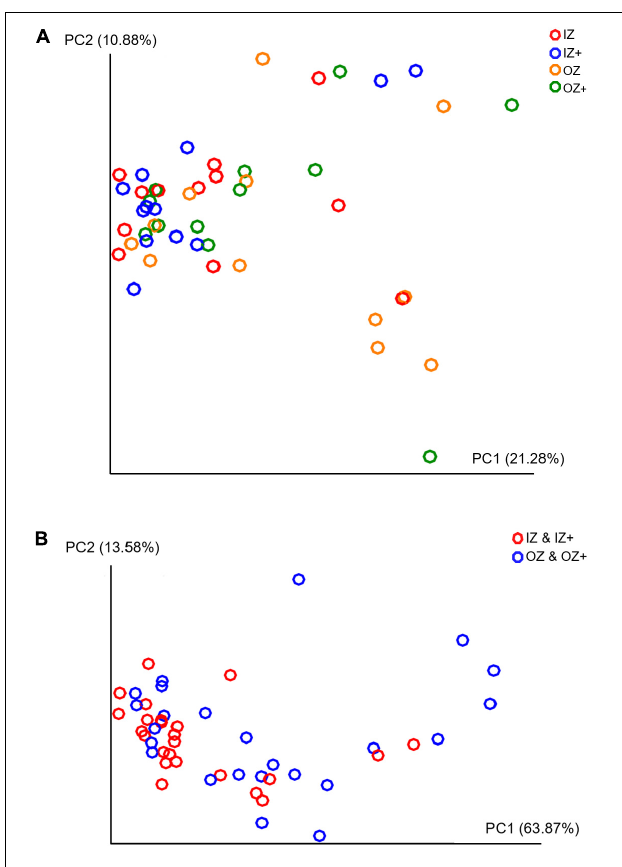
FIGURE 2 | Beta diversity metrics. Principal coordinates analysis (PCoA) of unweighted UniFrac distances of fecal bacteria associated with diets supplemented with inorganic (IZ and IZ +) and organic (OZ and OZ +) Zn sources without (IZ and OZ) and with (IZ + and OZ +) the addition of a multi-enzymatic complex from the solid-state fermentation of Aspergillus niger (A) and weighted UniFrac distances of fecal bacteria associated with diets supplemented with inorganic and organic Zn (B)